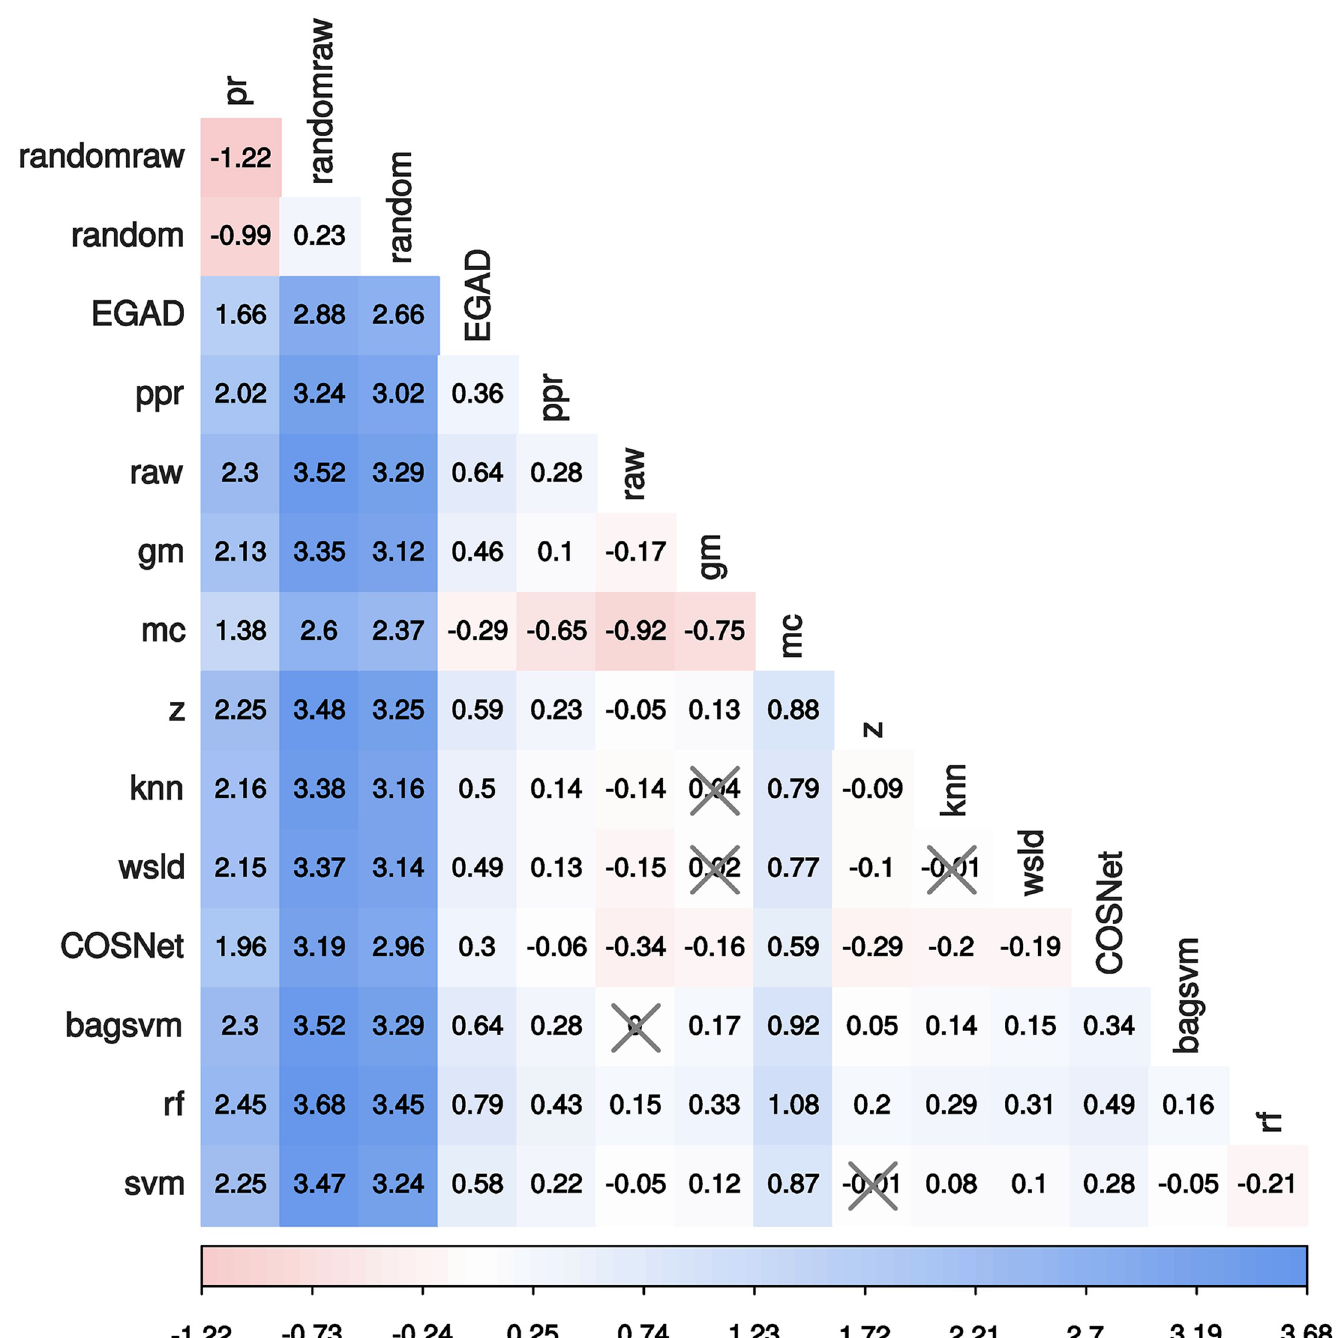
Fig 4. Pairwise contrasts on top 20 hits predicted by the main quasipoisson explanatory model. Differences are expressed in the model space. Most of the pairwise differences are significant (Tukey’s test, p < 0.05) – non-significant differences have been crossed out.